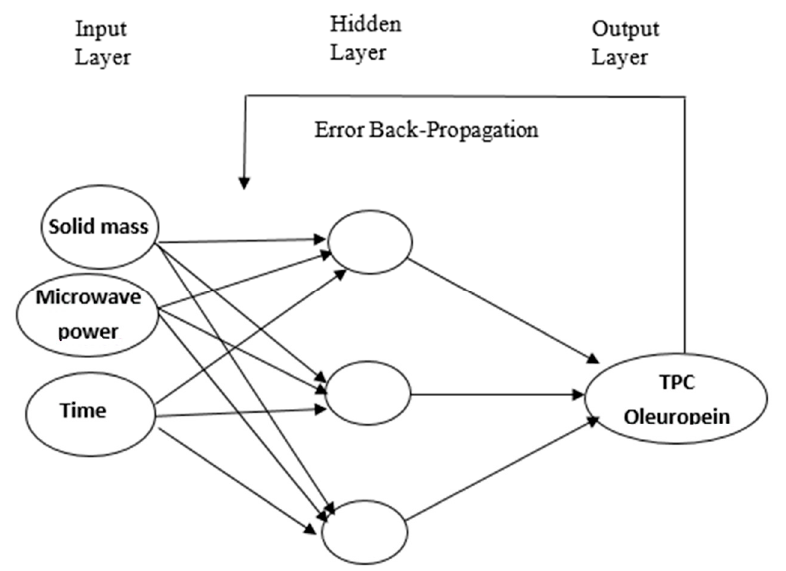
Figure 4. The feed-forward multilayer artificial neural network model with a back-propagation learning algorithm.